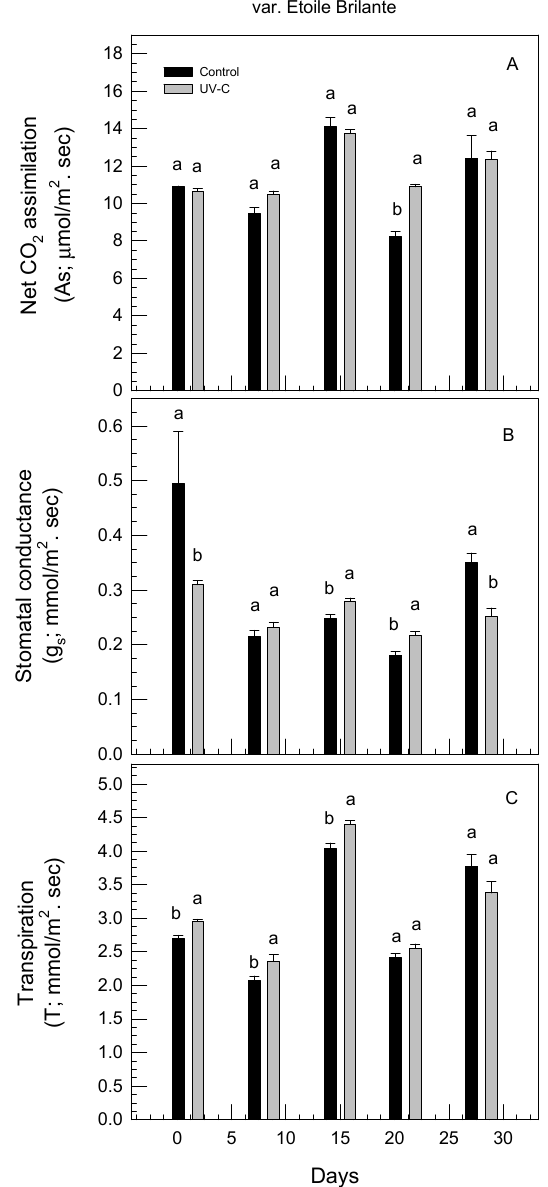
Figure 4. Net CO 2 assimilation ( A ), stomatal conductance ( B ) and transpiration ( C ) of var. “toile Brilante” rose plants irradiated with 2.5 kJ/m 2 of left untreated (controls) over a three-week period during GST. Data are means ± S.E. Different letters indicate significant differences between treatments at p = 0.05.